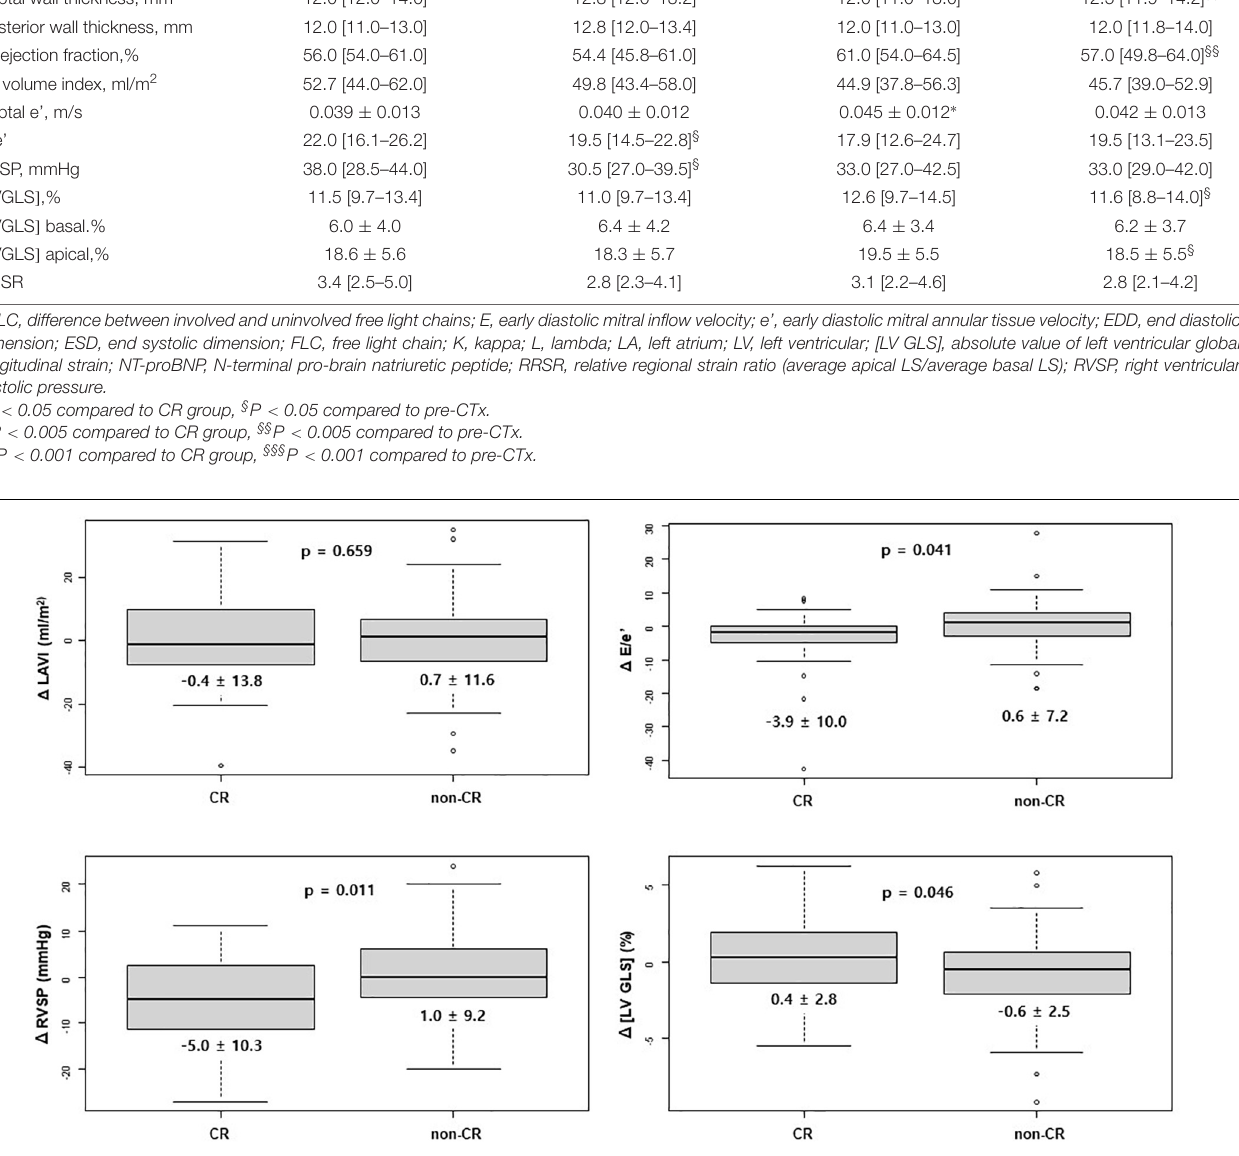
FIGURE 1 | Change in echocardiographic value after chemotherapy between the CR and non-CR groups. CR, complete response; E, early diastolic mitral inflow velocity; e’, early diastolic mitral annular tissue velocity; LAVI, left atrium volume index; [LV GLS], absolute value of left ventricular global longitudinal strain; RVSP, right ventricular systolic